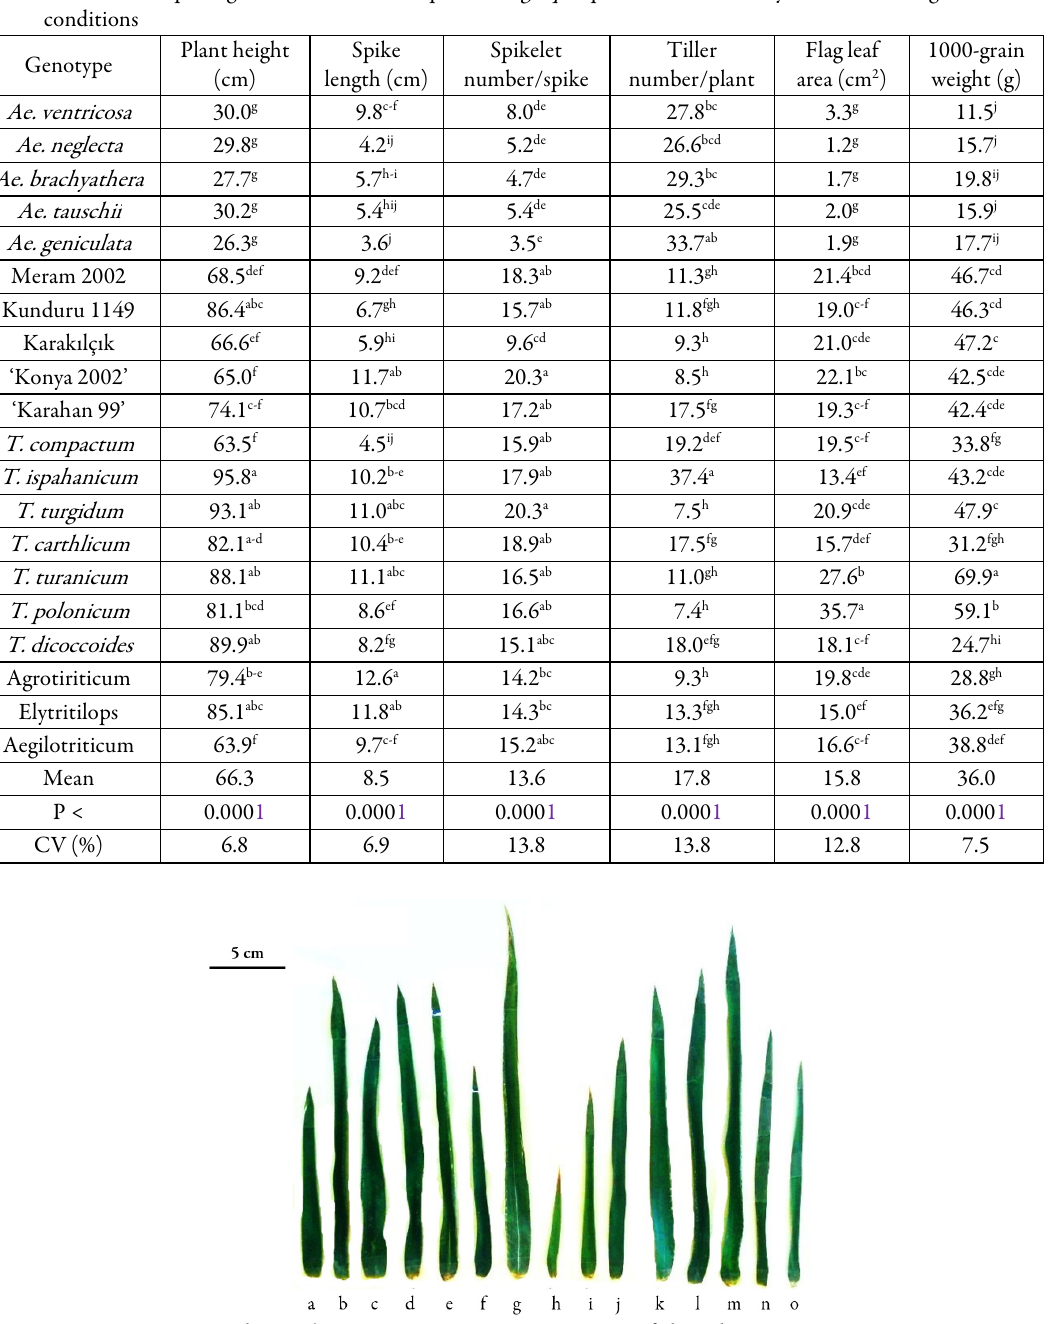
Figure 3. An image indicates the genotypic variations in FLA in rainfed condition Letters are the representatives of T. aestivum cv. ‘Karahan 99’ (a), T. durum cv. ‘Kunduru 1149’ (b), T. aestivum cv. ‘Konya 2002’ (c), T. durum cv. ‘Meram 2002’ (d), ‘Karakılçık’ (e), ‘Elytritilops’ (f), T. polonicum (g), T. dicoccoides (h), ‘Aegilotriticum’ (i), T. carthlicum (j), T. turgidum (k), T. compactum (l), T. turanicum (m), ‘Agrotriticum’ (n), and T. ispahanicum (o). The fully expanded flag leaves were excised from plants. Scale bar is 5